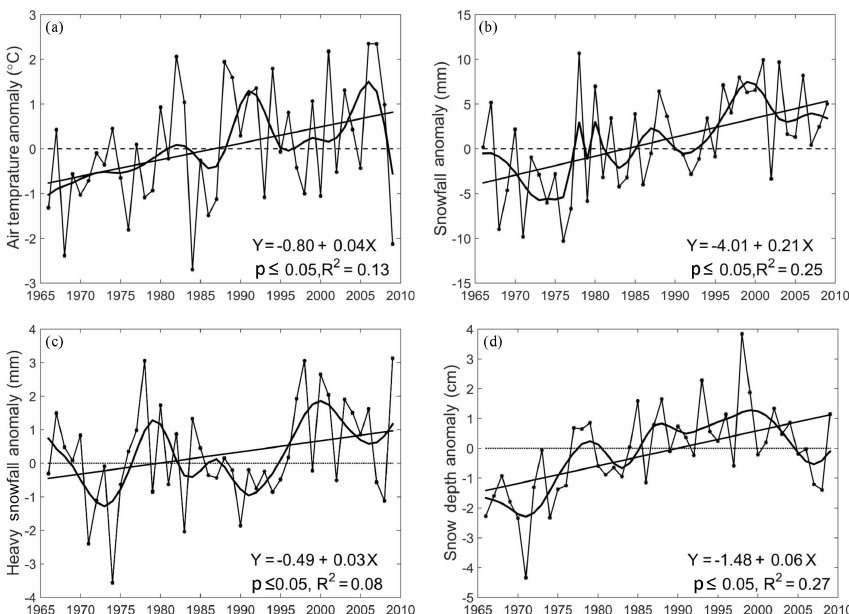
Figure 10. Composite of the anomalies of annual mean air temperature (a) , annual snowfall (b) , annual heavy snowfall (c) , and annual mean snow depth (d) from November through March during 1966–2009 with respect to the 1971–2000 mean across the former USSR. The composite anomaly was calculated by the sum of anomalies from all stations divided by the number of stations at a given year. The line with dots is the composite of the annual means. The thick curve represents the smoothed curve using wavelet analysis. The thick line presents a linear regression trend.